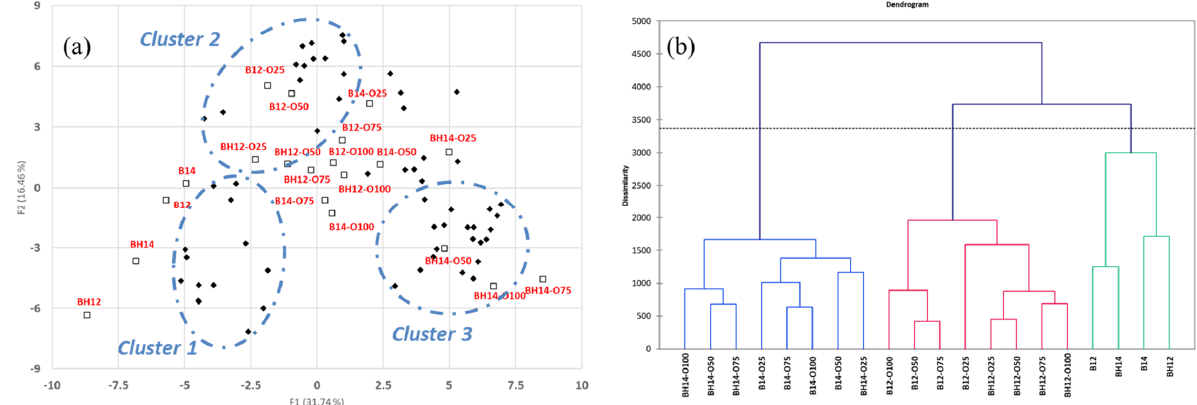
Figure 1. PCA ( a ) and AHC ( b ) of volatile compounds of peanut oil during the oxidation process.